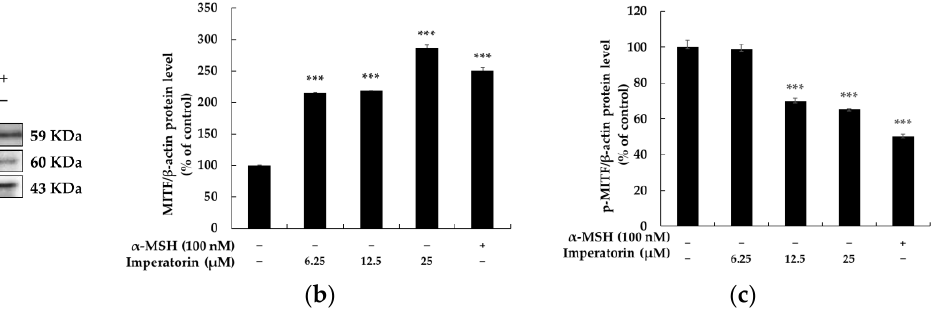
Figure 4. The effects on the protein expression and phosphorylation of MITF in B16F10 melanoma cells when the cells were treated with imperatorin (25, 12.5, and 6.25 µ M) for 24 h: ( a ) Western blotting results; ( b ) protein levels of MITF; ( c ) phosphorylation level of MITF. β -Actin was used as a loading control. The results are presented as the mean ± SD from three independent measurements using ImageJ software. *** p < 0.001 vs. the untreated control